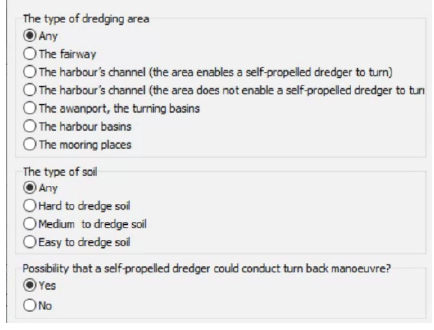
Figure 3. Types of dredging area and soil.